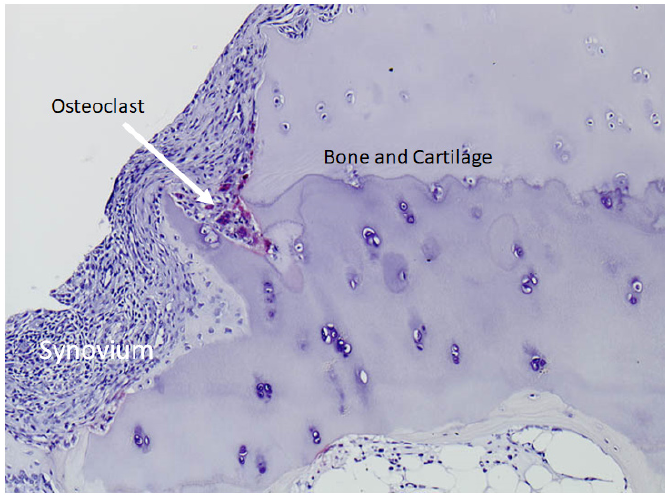
Figure 1. Bone erosion in rheumatoid arthritis. The proliferating synovium stimulates osteoclast differentiation, and many osteoclasts are observed at the synovium–bone interface